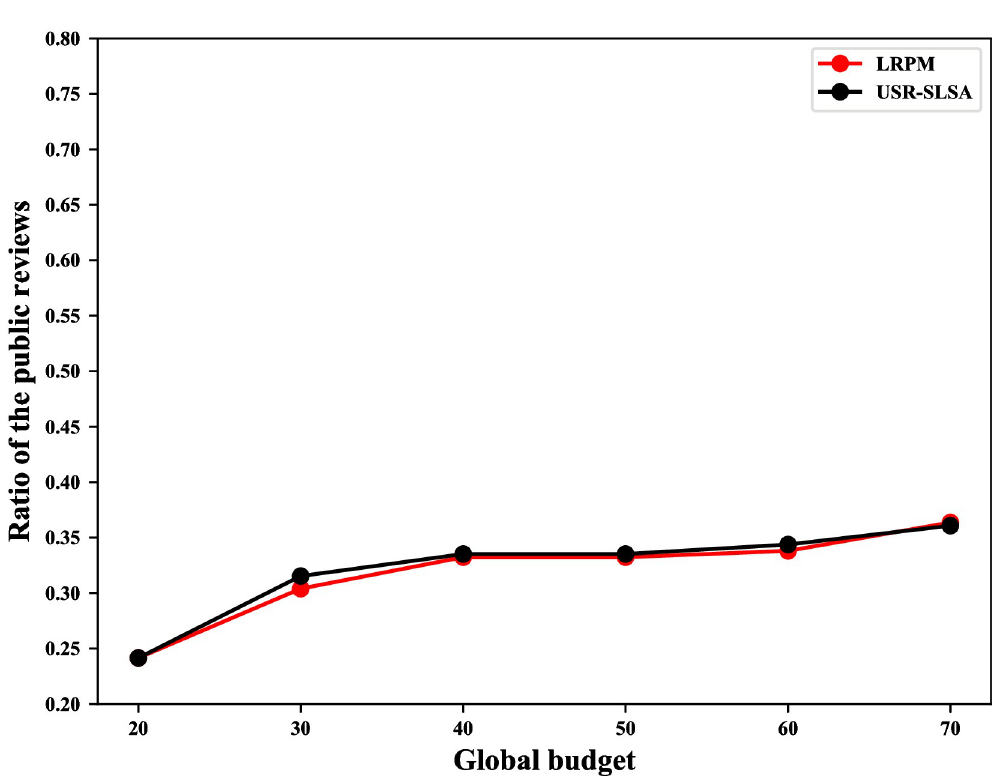
Fig 10. Ratio of the public reviews for different global budget (SPs for two methods receive the same numbers of reviews).